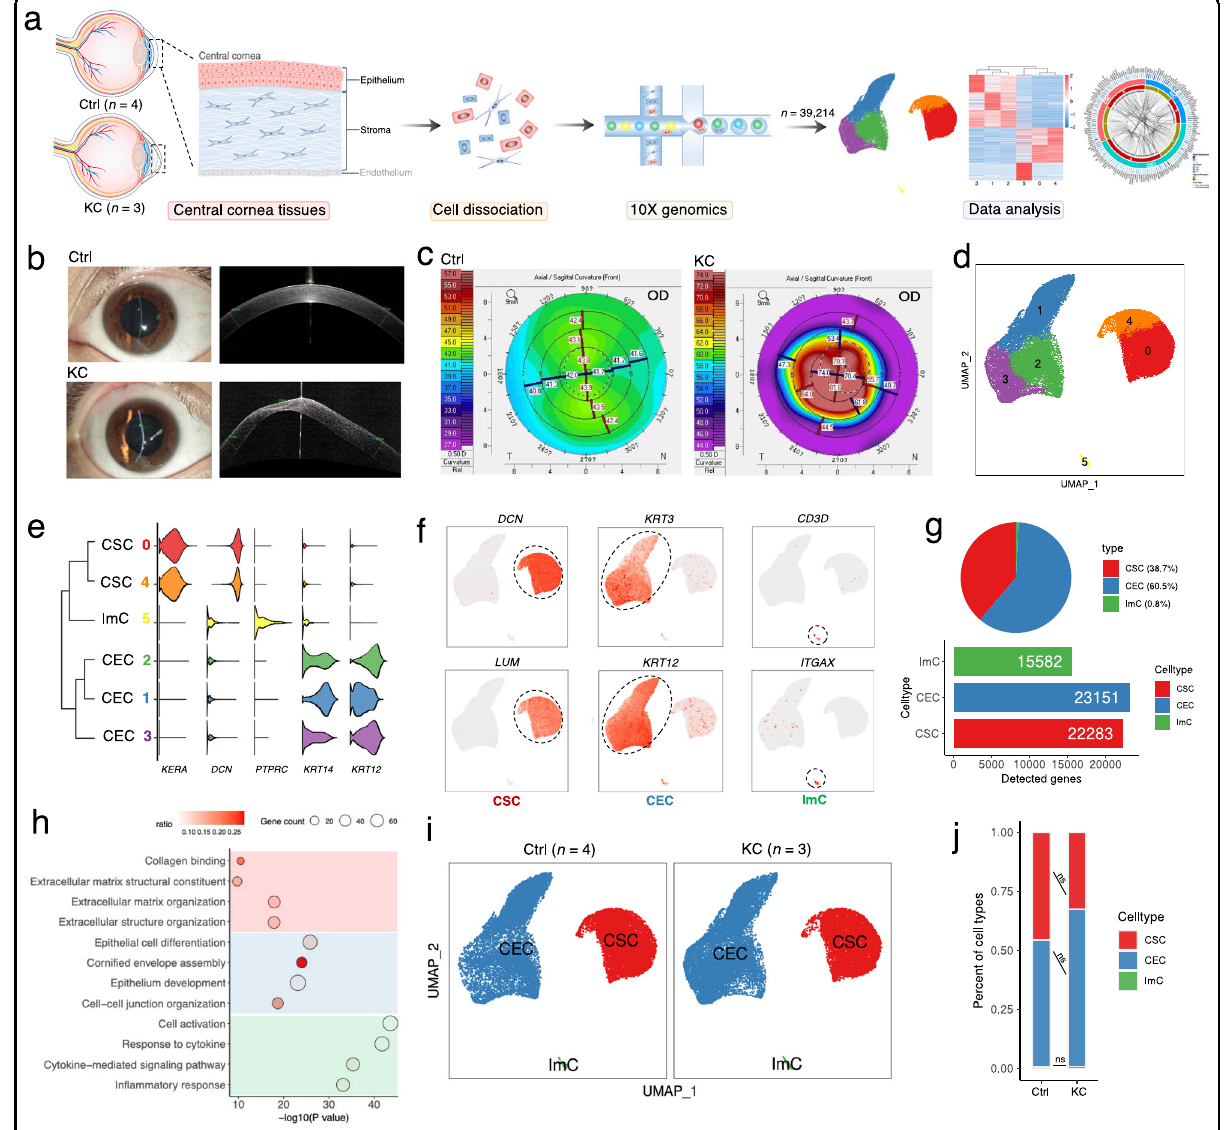
Fig. 1 Overview of cellular compositions of KC and Ctrl human corneas delineated by scRNA-Seq analysis. a Overview of the experimental work fl ow in this study. In the schematic of diagram of the human cornea, the corneal epithelium and stroma (labeled in black) from the central cornea were subjected to downstream experiments, and the corneal endothelium (labeled in gray) was excluded (see Materials and Methods). b , c Anterior segment OCT ( b ) and Scheimp fl ug optical cross-sectional analysis ( c ) showed typical symptoms of keratoconus cornea. d UMAP representation of human corneal cells colored into 6 distinct clusters. e , f Expression levels ( e ) and distribution ( f ) of well-known representative cell markers across clusters. g The cell type proportions (top panel) and the number of detected genes per cell type (bottom panel). h Representative GO terms of speci fi cally expressed genes in each cell type. i UMAP plot of human corneal cells colored by three major cell types in KC and Ctrl groups. j Bar plot representing the differences in relative proportion of major cell types between Ctrl and KC samples. ns, no signi fi cance (Student ’ s t -test). KC keratoconus; Ctrl control; CSC corneal stromal cell; CEC corneal epithelial cell; ImC immune